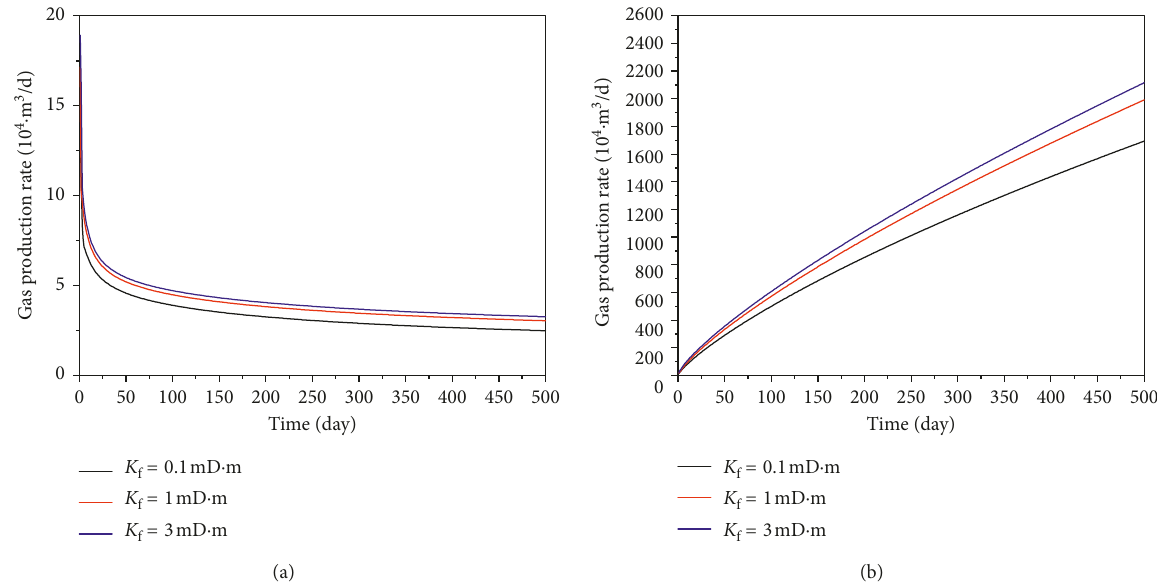
Figure 20: Effect of fracture conductivity on behavior of the multistage fractured horizontal well: (a) gas production rate; (b) cumulative gas